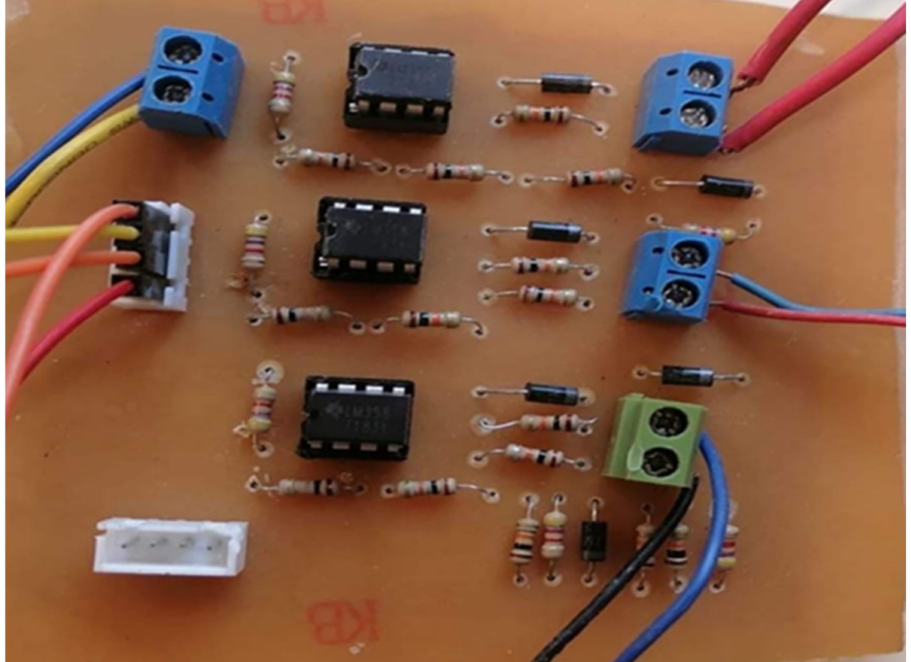
Figure 17. Voltage-sensing